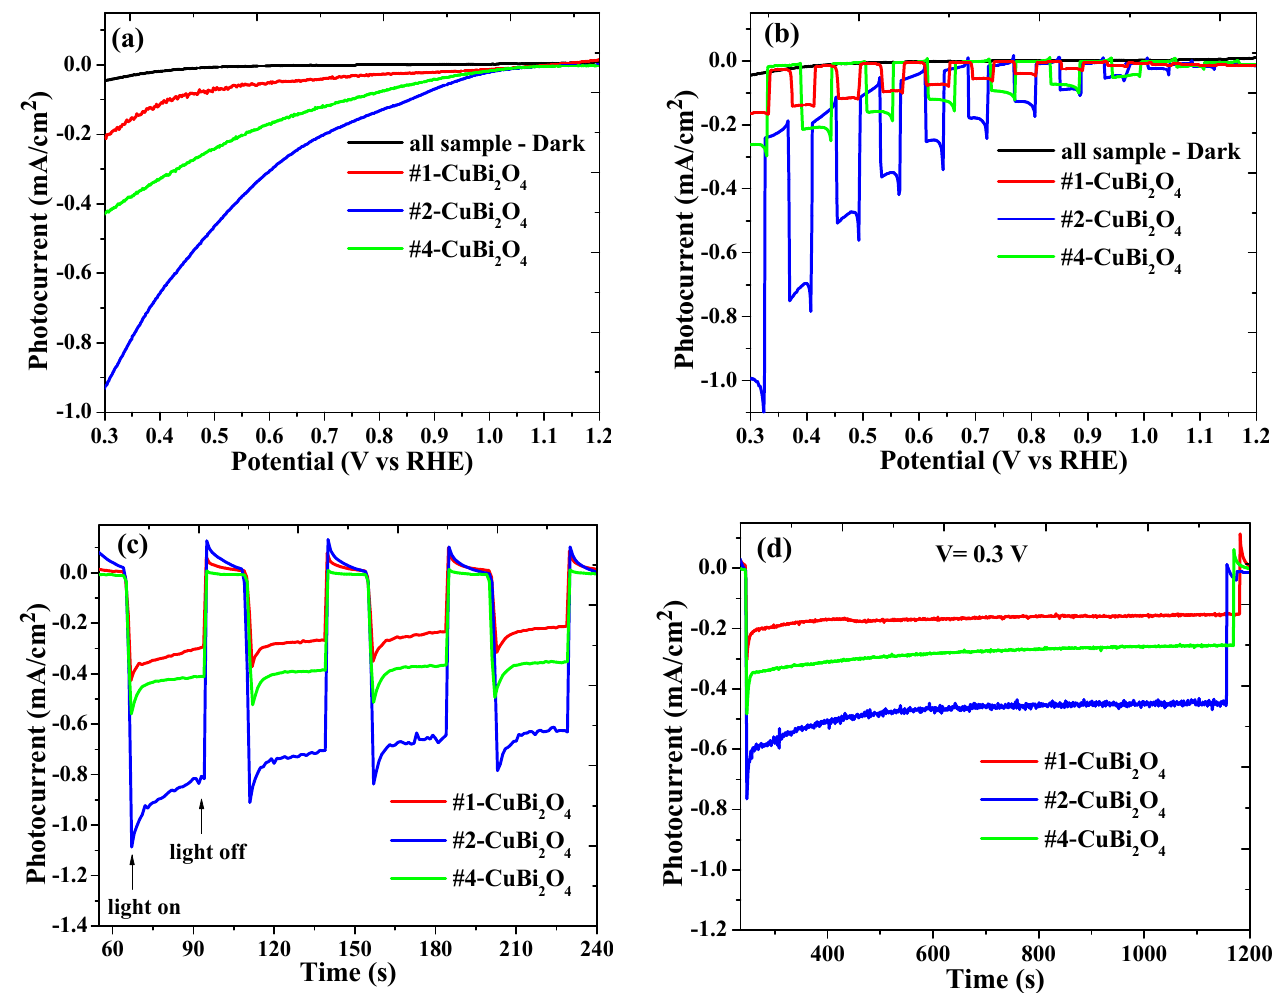
Figure 4. ( a ) LSV, ( b ) chopped LSV, ( c , d ) photocurrent response of the #1-CuBi 2 O 4, #2-CuBi 2 O 4 , and #4-CuBi 2 O 4 photocathodes. Under 100 mW/cm 2 illumination, the electrolyte was a 0.5 M aqueous solution of Na 2 SO 4 .